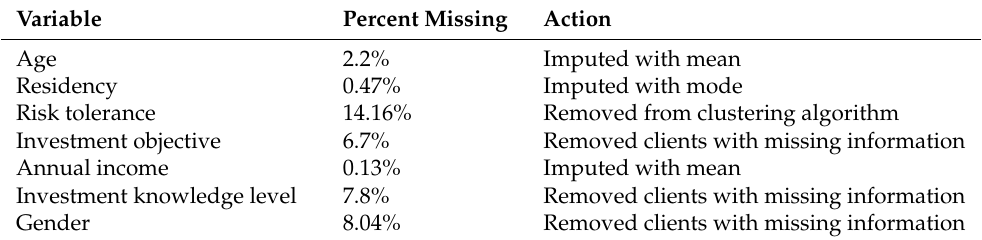
Table A2. Summary of missing values and imputation for clustering.